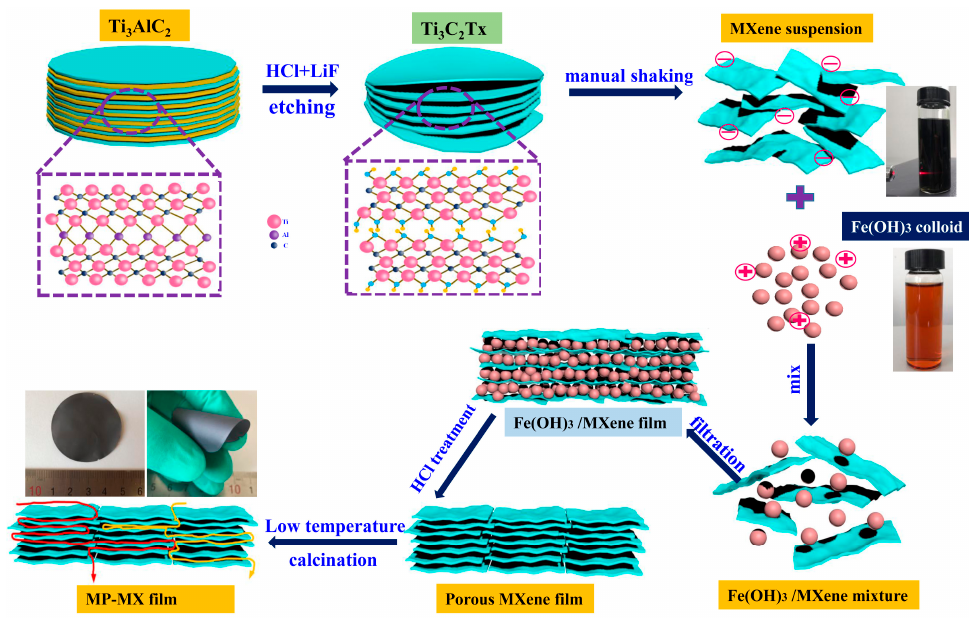
Figure 11. Schematic diagram of synthesis of nanoporous MXene film; reproduced from [51], with the permission of the Royal Society of Chemistry.